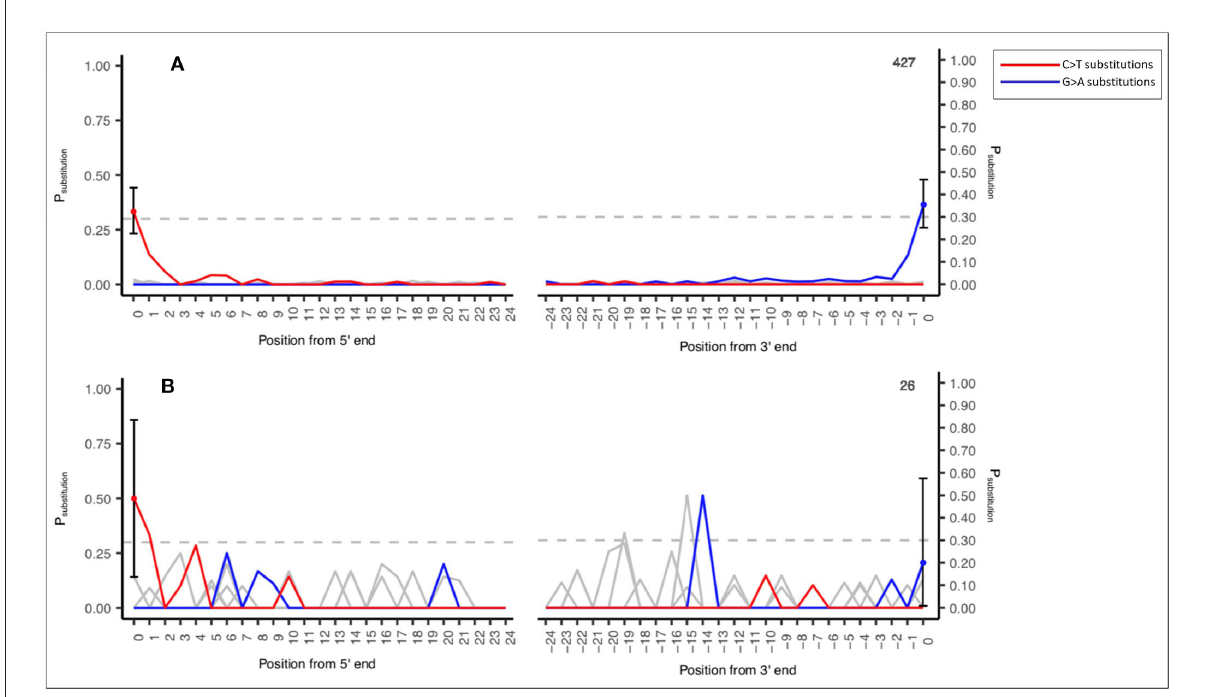
FIGURE2 Example MetaDamage output— (A) High number of input sequences (427) and an observed deamination rate of 0.33333 with ancient DNA signal. (B) Low number of input sequences (26) and an observed deamination rate of 0.5 with ancient DNA signal. Shotgun datasets provided by Everett